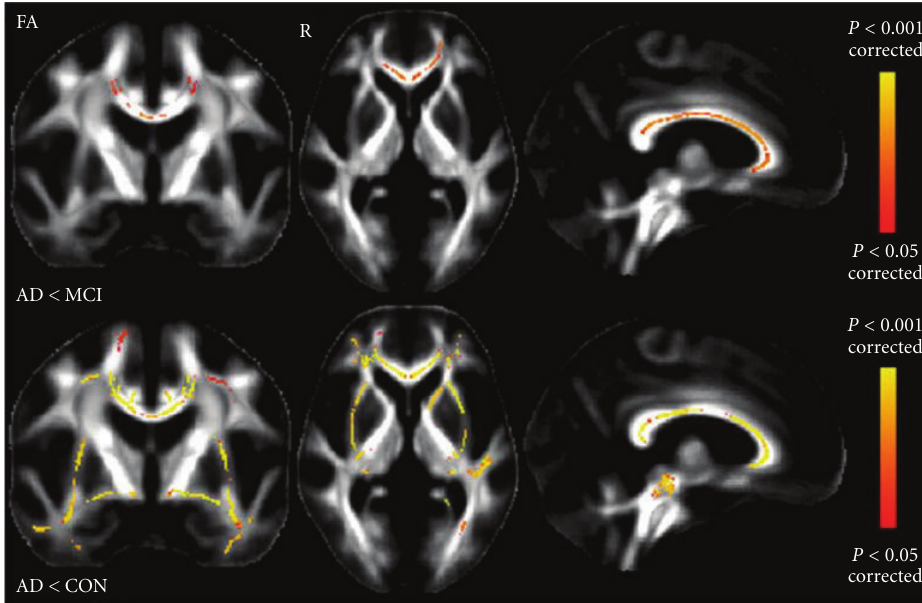
Figure 13: First row: significant FA results showing the contrast MCI > AD; second row: significant FA results showing CON (controls) > AD (adapted with permission from